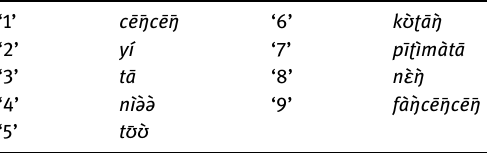
Table 2: Akebu simple numerals from ‘ 1 ’ to ‘ 9